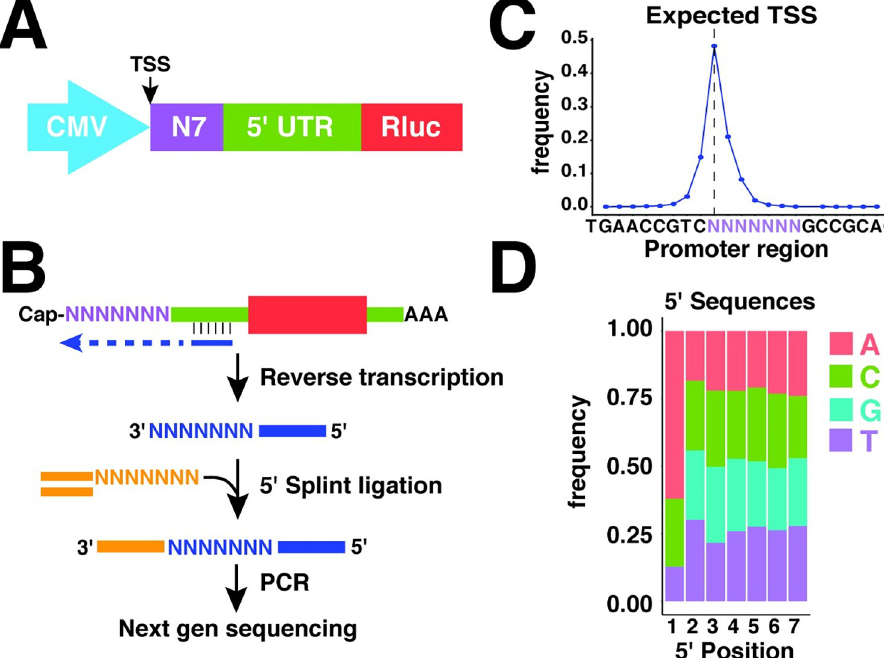
Fig 1. 5pseq library design. (A) Organization of the 5pseq expression plasmid. (B) Strategy for library preparation. Extracted mRNA is reverse transcribed with a library-specific primer. A 5 0 linker is then attached by